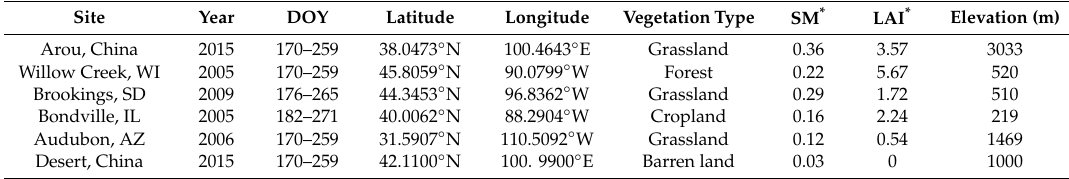
Table 1. Environmental characteristics of the study sites.